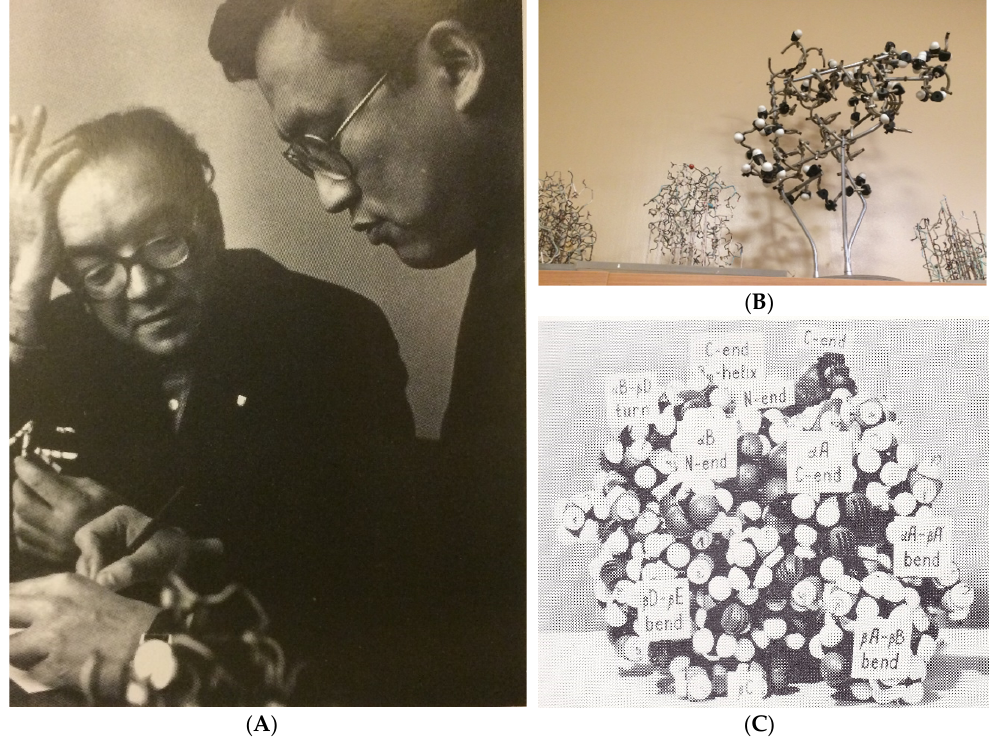
Figure 2. The early history of protein secondary structure prediction. ( A ) Oleg Ptitsyn (with hand in hair) and V.I. Lim study physical models of proteins and peptides. ( B ) Recent photo of some of the wire models used in Ptitsyn’s lab before (and also after) computer graphics systems became available. ( C ) Model of one of the early structure predictions by Ptitsyn’s group. One of us (G.V.) spent time in the early 90s with Ptitsyn and Finkelstein looking at these models, at which time Oleg told him that “looking at models is the best theoretical approach”, a lesson G.V. never forgot and taught all his students, including most coauthors on this article.